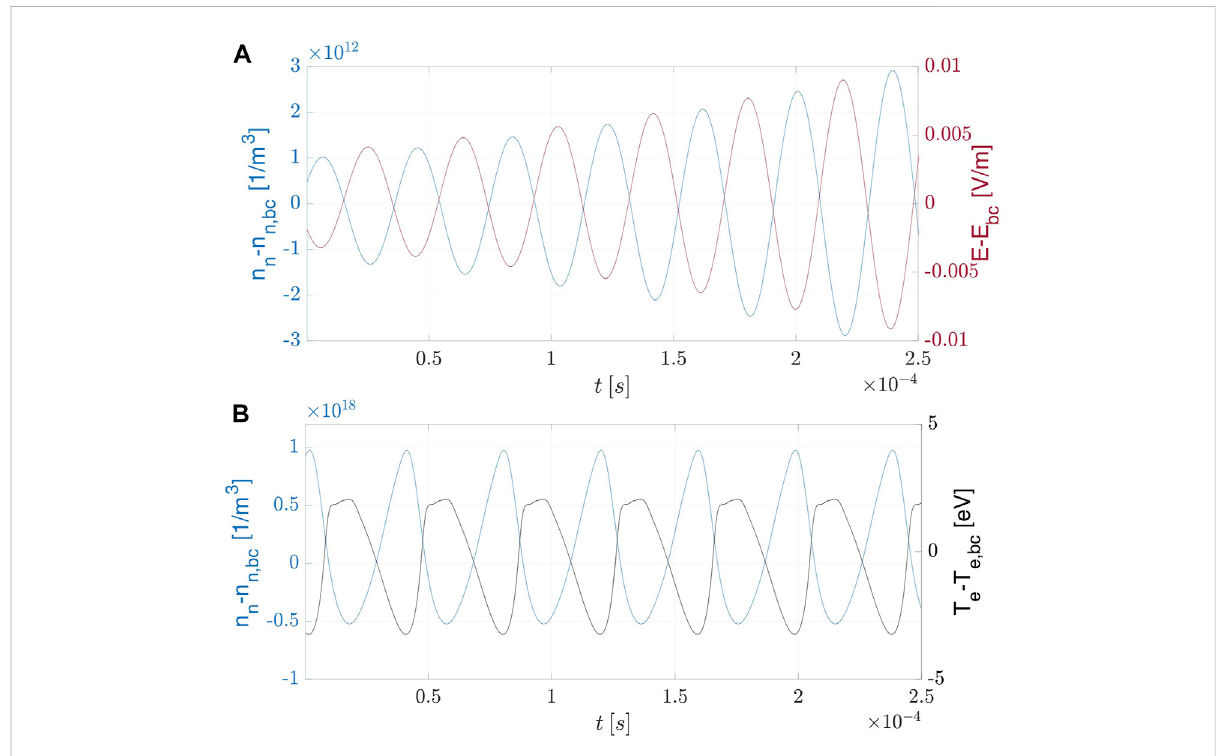
FIGURE 4 Oscillationsintimeofneutraldensity(blue)andelectric fi eld(red)aroundtheirbasestatevaluesatpoint z = L c /2 (A) atincipientinstabilityand (B) of neutral density and temperature (black) on the limit